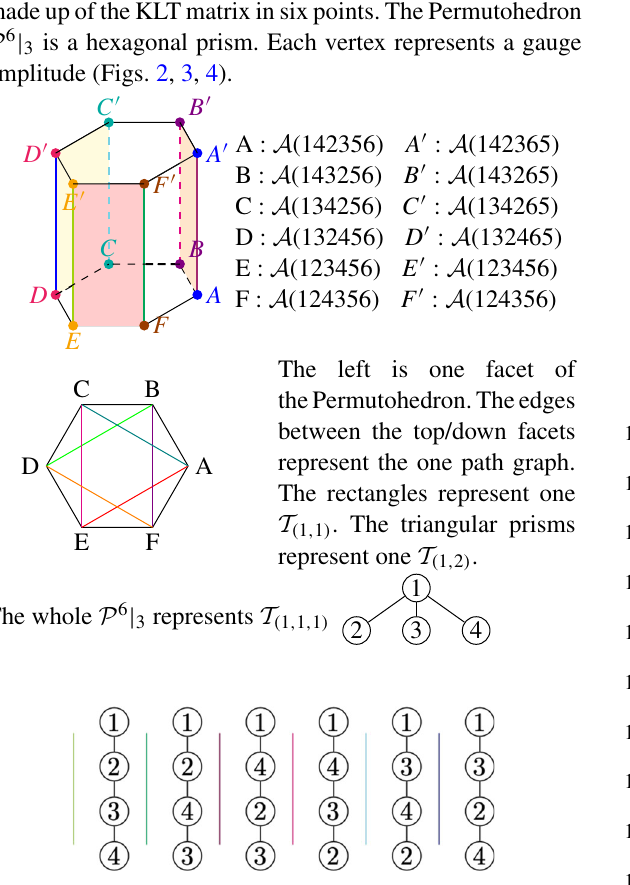
Fig. 2 The edges between the top/down facets represent the one path graph